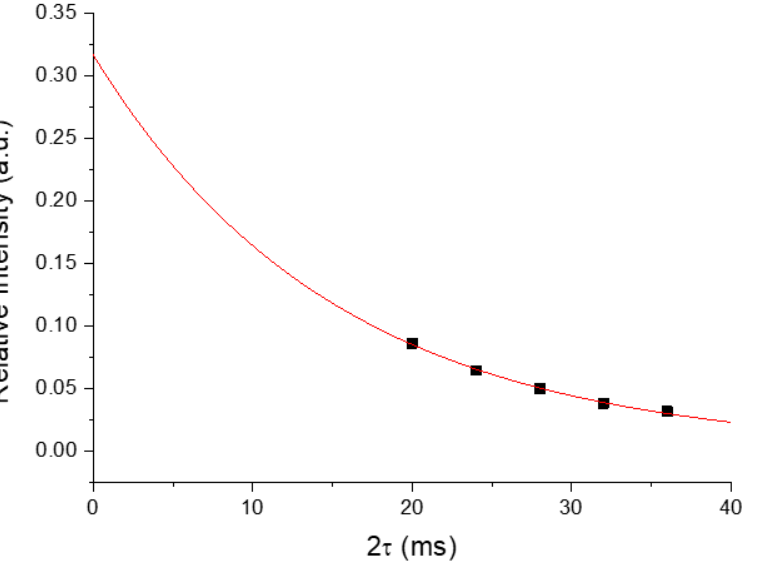
Figure 2. Signal intensities as a function of the dipolar dephasing time acquired for a typical human dentin sample. The intensity extrapolated at 2 τ = 0 was used to estimate the amount of hydroxyl-deficient apatite (HDAp). Note that only the data points with τ ≥ 10 ms were used for the fitting, because our control experiment showed that the HAp signal was suppressed for τ ≥ 10 ms.